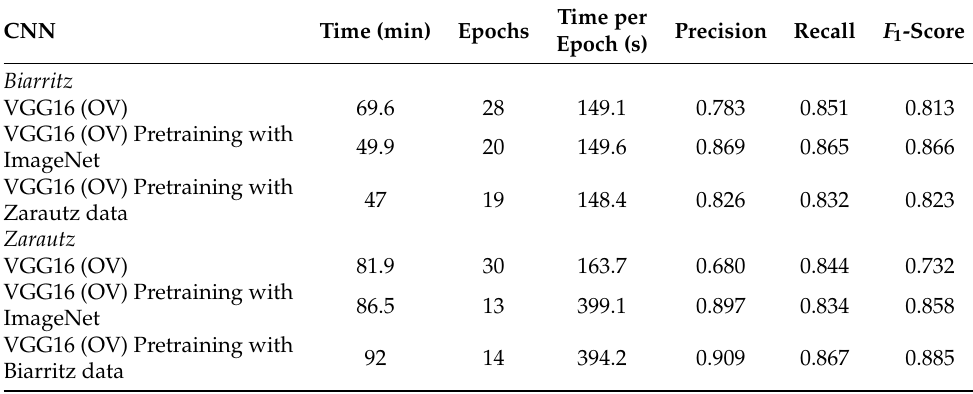
Table 4. Performances of CNN learning from scratch, pre-trained with ImageNet, or pre-trained with the other site for Biarritz and Zarautz. “OV” stands for oversampling. CNN Time (min) Epochs